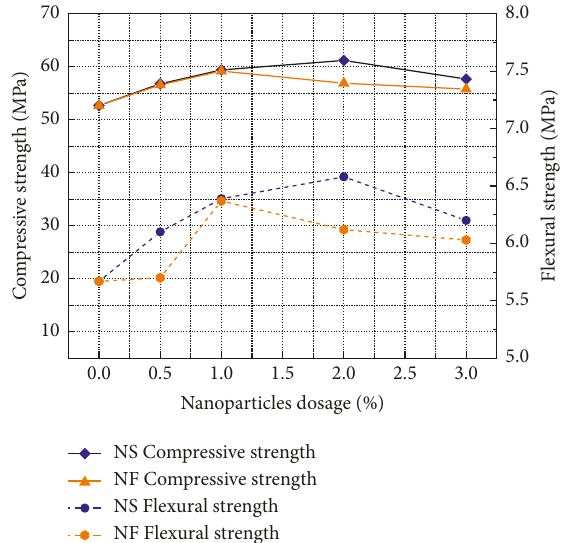
Figure 7: Compressive and flexural strength of